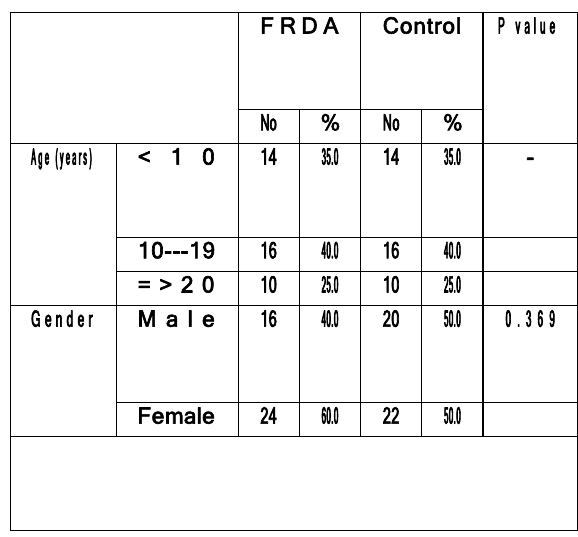
Table (3-1)The distribution of patients according to age and gender